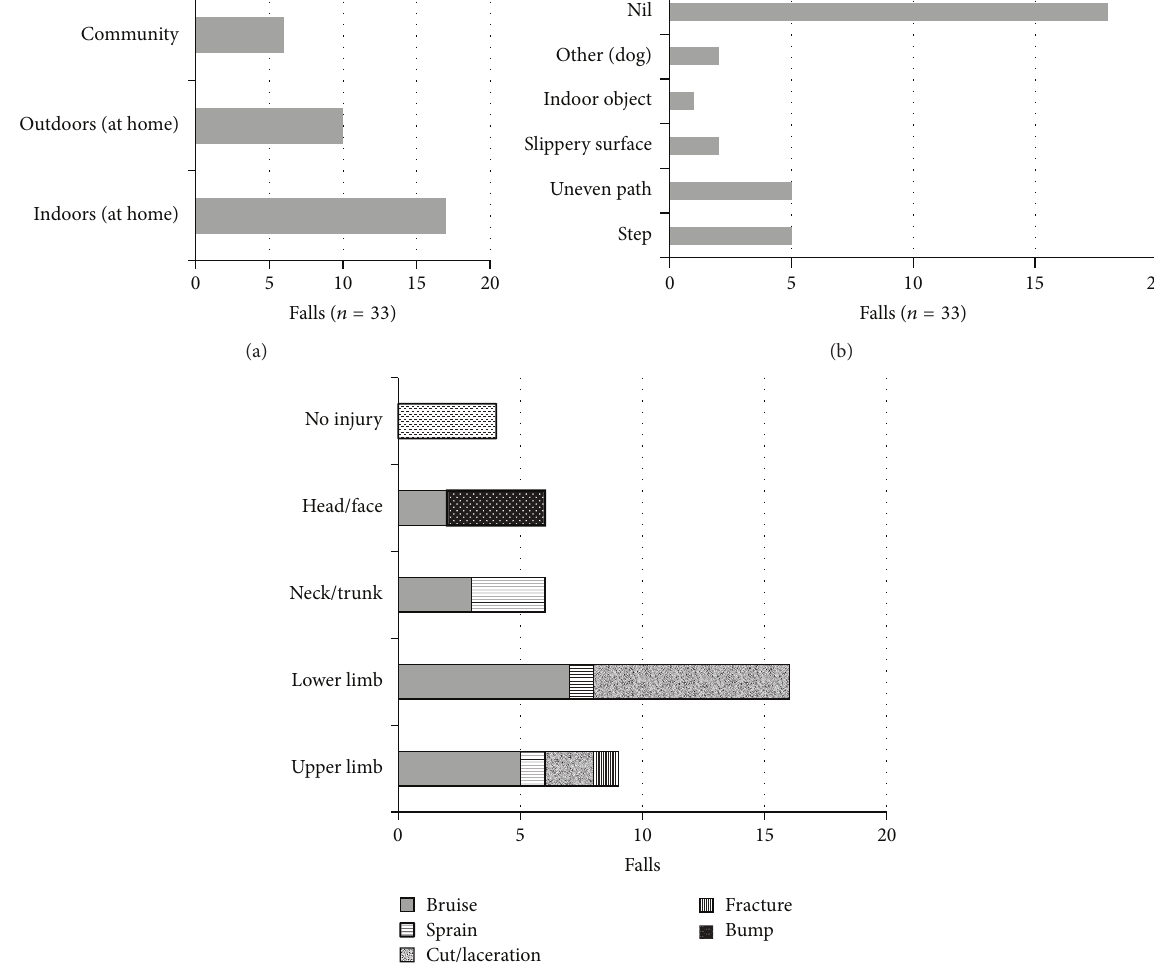
“Even though I do not fall that often I’m constantly aware of it” (Participant